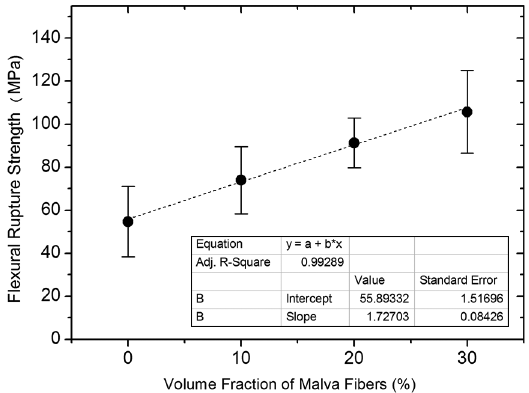
Figure 4. Variation of the flexural rupture strength with the volume fraction of malva fibers in epoxy composites.